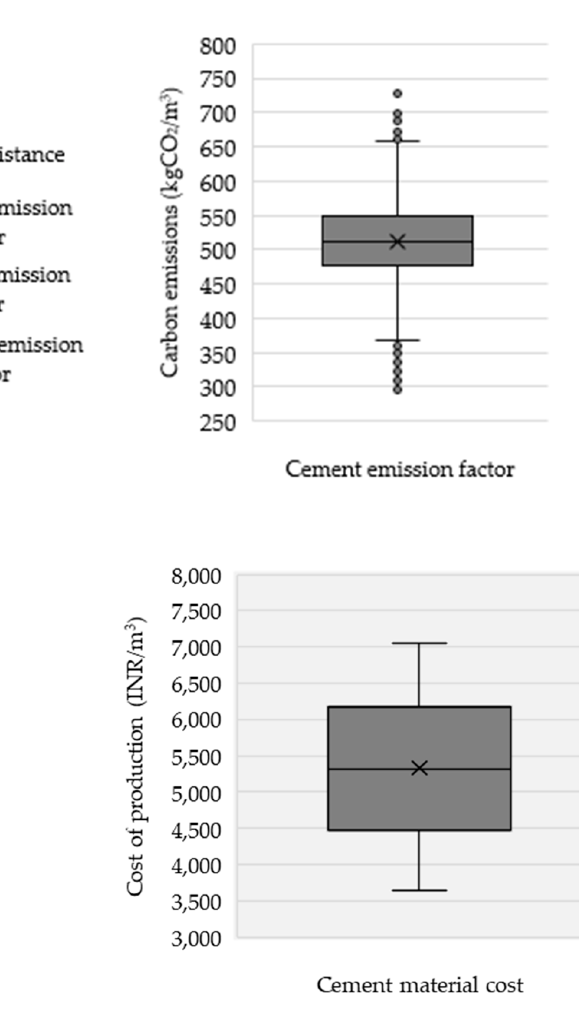
Figure 8. Sensitivity analysis